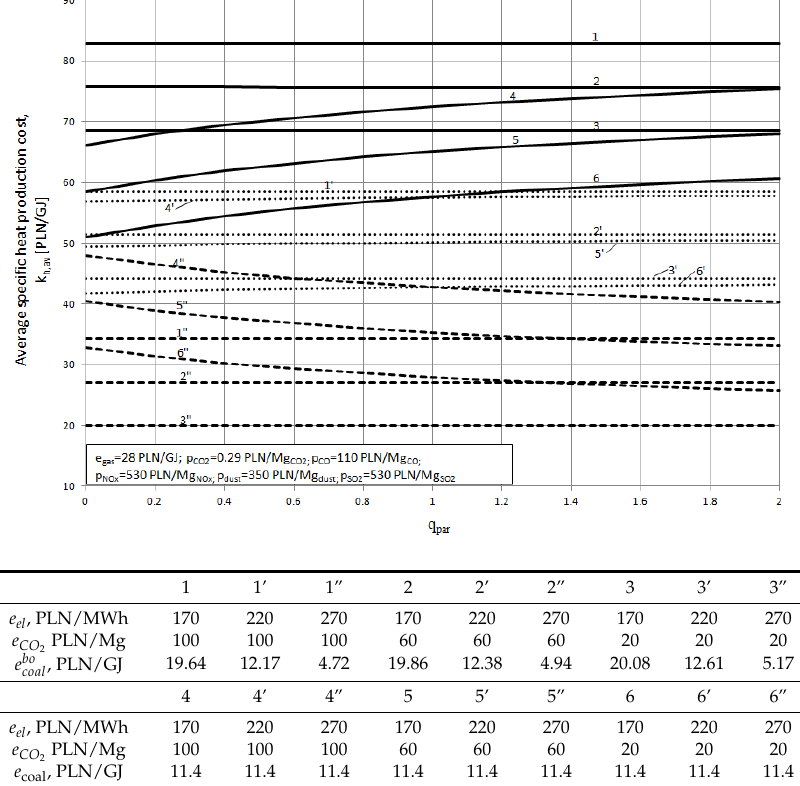
Figure 10. Average specific cost of heat production as a function of q par with the purchase price of carbon dioxide emission allowances as a